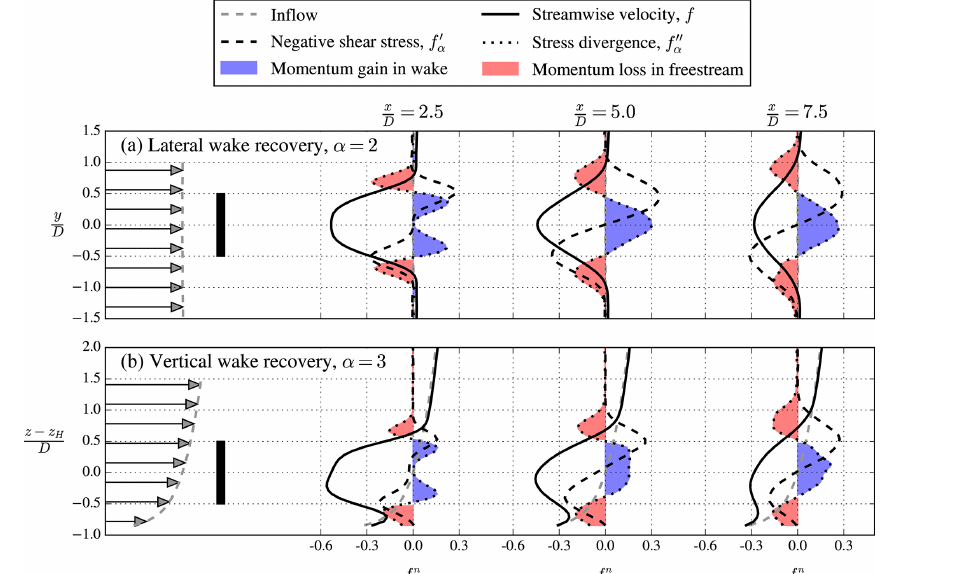
Figure 3. Normalized profiles of streamwise velocity, negative shear stress, and shear stress divergence from a single wake